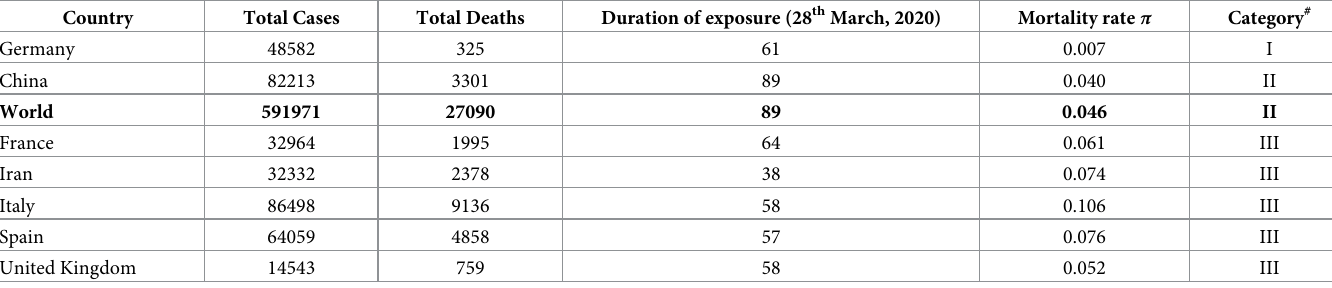
Table 3. Duration of exposure and mortality rates in different countries due to COVID-19 on 28 th March, 2020.